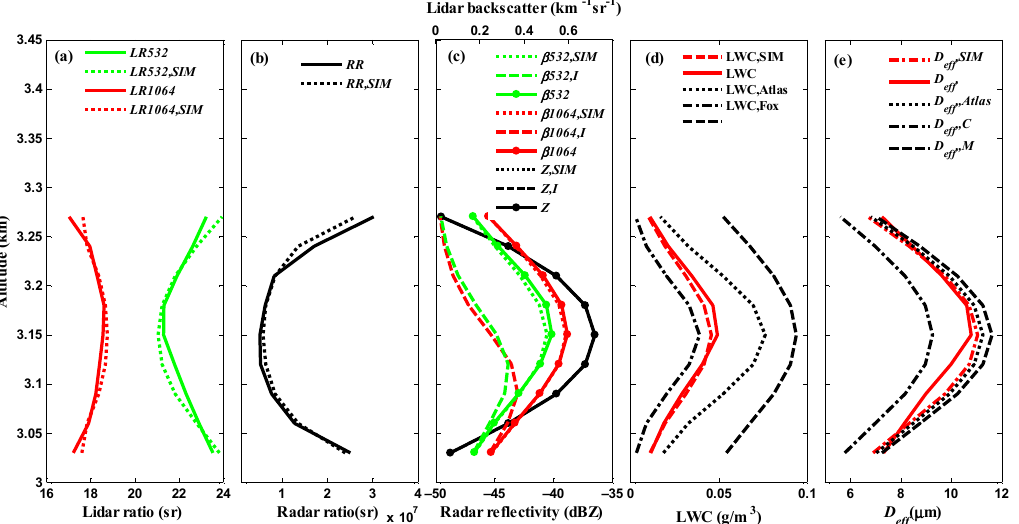
Figure 7. Comparison of the iteration results (solid line) with the simulation (SIM, dot line) in profile. The DSD parameter was the same as in Figure 6a: ( a ) lidar ratio at different wavelengths ( LR 532 , LR 1064 ); ( b ) radar ratio ( RR ); ( c ) lidar backscatter at different wavelengths ( β 532 , β 1064 ) and radar reflectivity factor ( Z ) (initial value subscript I , dash line); the results of different Z were superimposed. ( d ) Liquid water content (LWC); ( e ) effective diameter ( D eff ) .